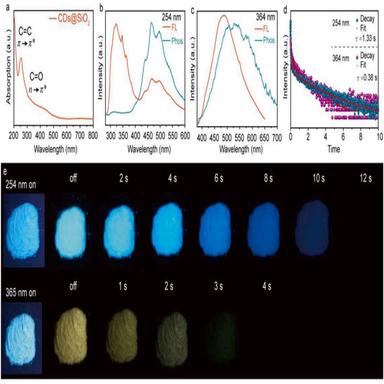
(a) UV–vis absorption spectrum of CDs@SiO2, (b, c) Fluorescence and phosphorescence emission spectra of CDs@SiO2 under excitation of 254 nm and 364 nm, respectively, (d) Time-resolved phosphorescence decay and fitting curves with 254 nm and 354 nm excitation and (e) Photographs of CDs@SiO2 powders under excitation with UV lamp, and after switch-off of UV lamp.